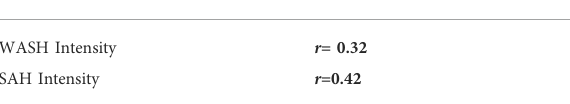
TABLE 1 The correlations between the WPSH intensity index, SAH intensity index, WPSH western ridge point index, and ridge line index with precipitation anomaly in August 2020 over